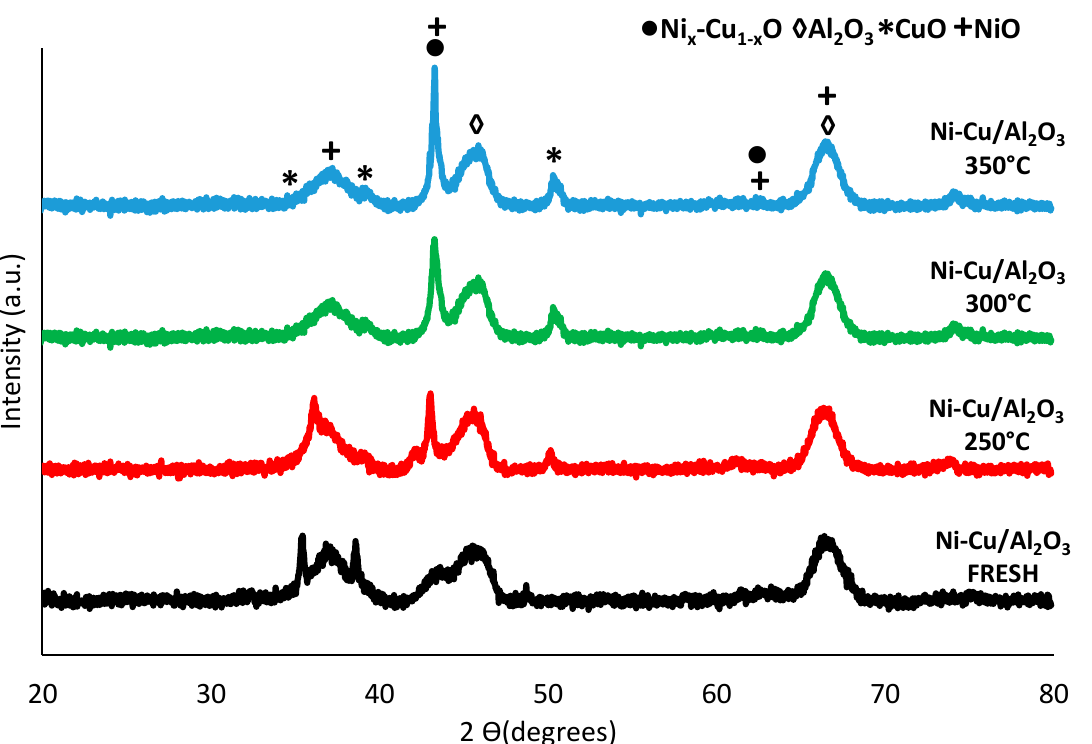
Figure 10. XRD of the fresh and recovered Ni ‐ Cu/Al2O3.